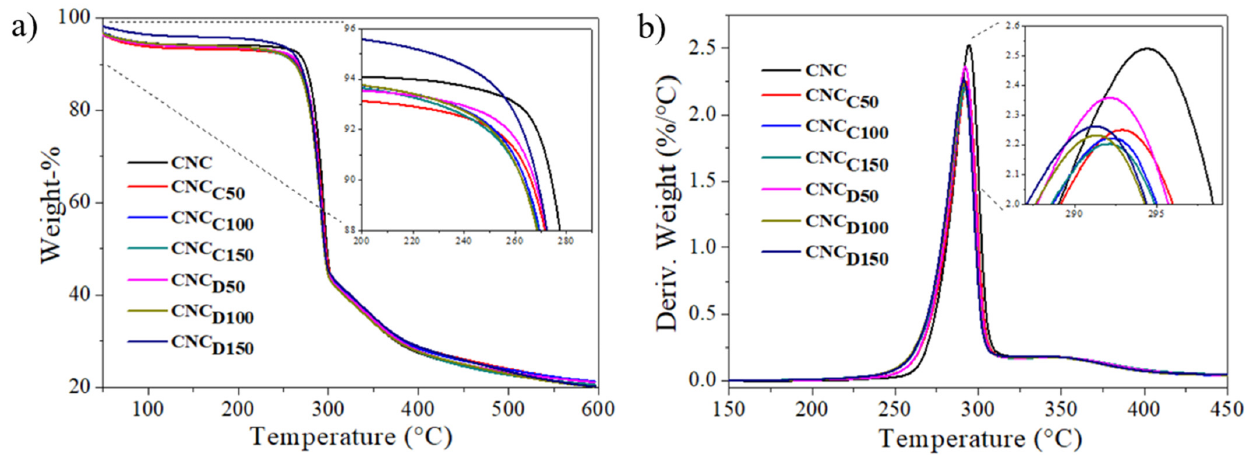
Figure 3. TGA thermogram ( a ) and mass loss rate ( b ) of CNCs and m -CNC’s. The crystallinity of the CNCs and m -CNCs was evaluated by X-ray diffraction (XRD)